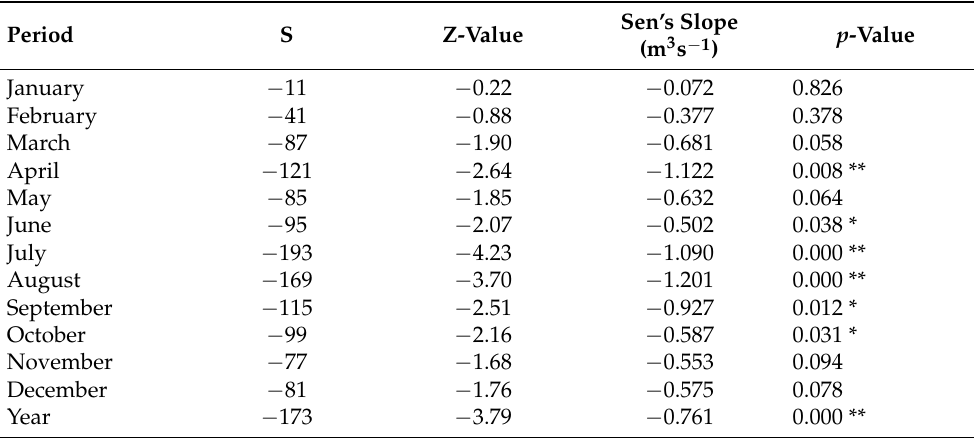
Table 4. Changes in mean monthly and annual flows through the Jeziorsko hydropower plant in the period 1995–2021.